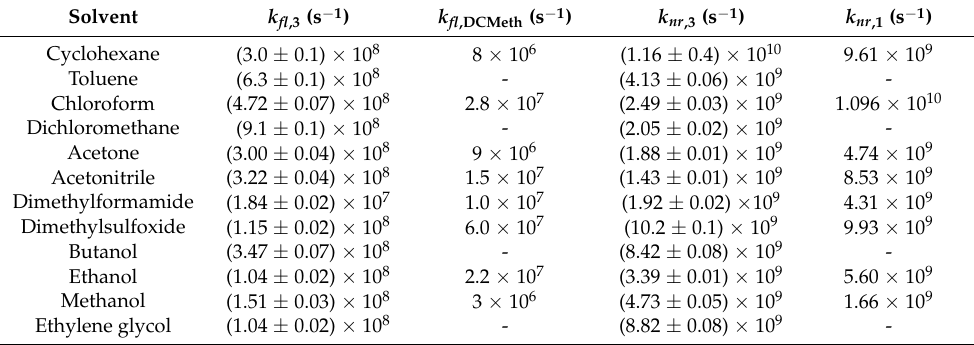
Table 9. Radiative decay rates, k fluo , 3 , and non-radiative decay rates, k nr , 3 , calculated for 3 in the different solvents of Table 1 according to Equations (2) and (3) are compared to those of DCMeth, k fluo ,DCMeth and k nr ,DCMeth , reproduced from [39] for the sake of straightforward comparison.